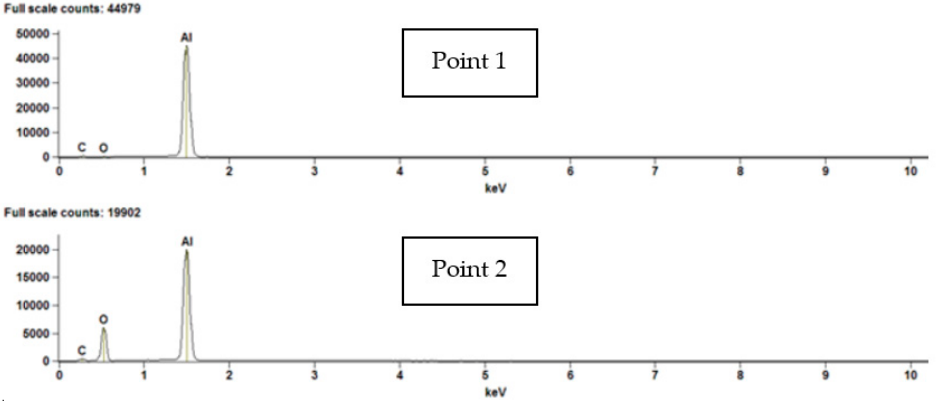
Figure 11. EDS of particle shown in Figure 10.